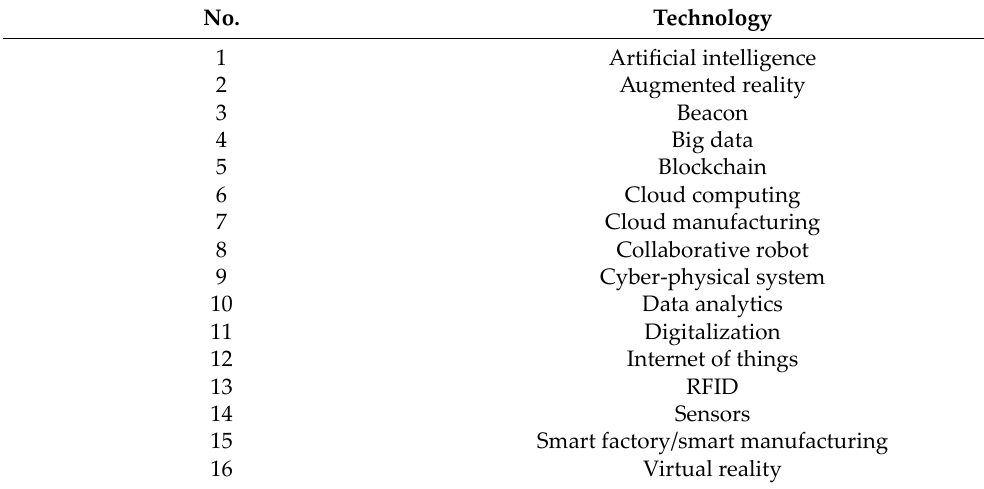
Table 1. The summary of technologies. No. Technology